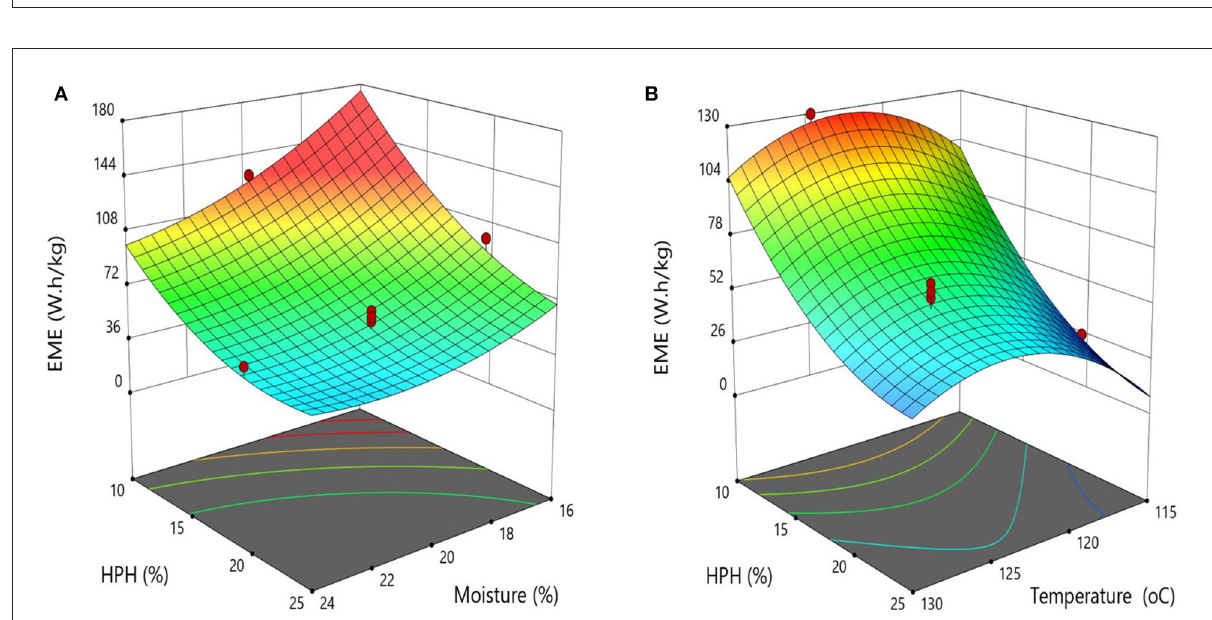
FIGURE1 Effect of HPH, moisture and temperature on EME. (A) Moisture vs. HPH (temperature 125 ◦ C and screw speed 220 RPM). (B) HPH vs. temperature (screw speed 220 RPM and humidity 20%).